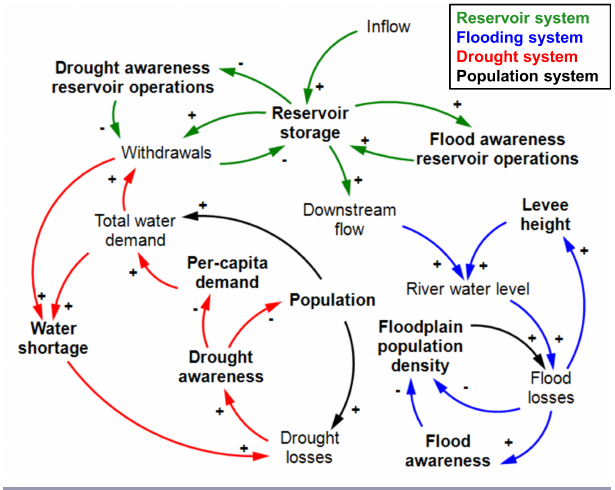
Fig. 3 . Causal loop diagram of the model where arrows are feedbacks between state variables (bold text) and fluxes, and the symbols + and – represent positive and negative feedbacks,